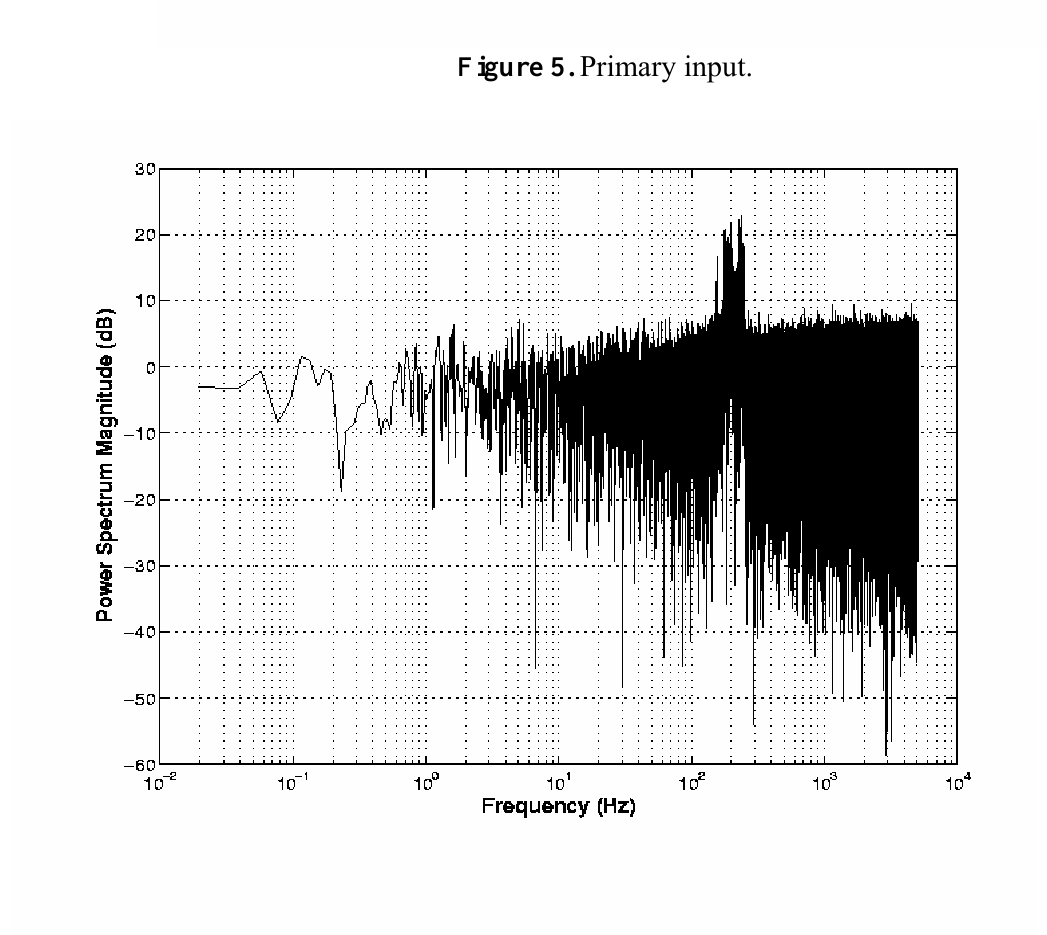
Figure 6. Power spectrum magnitude of the primary